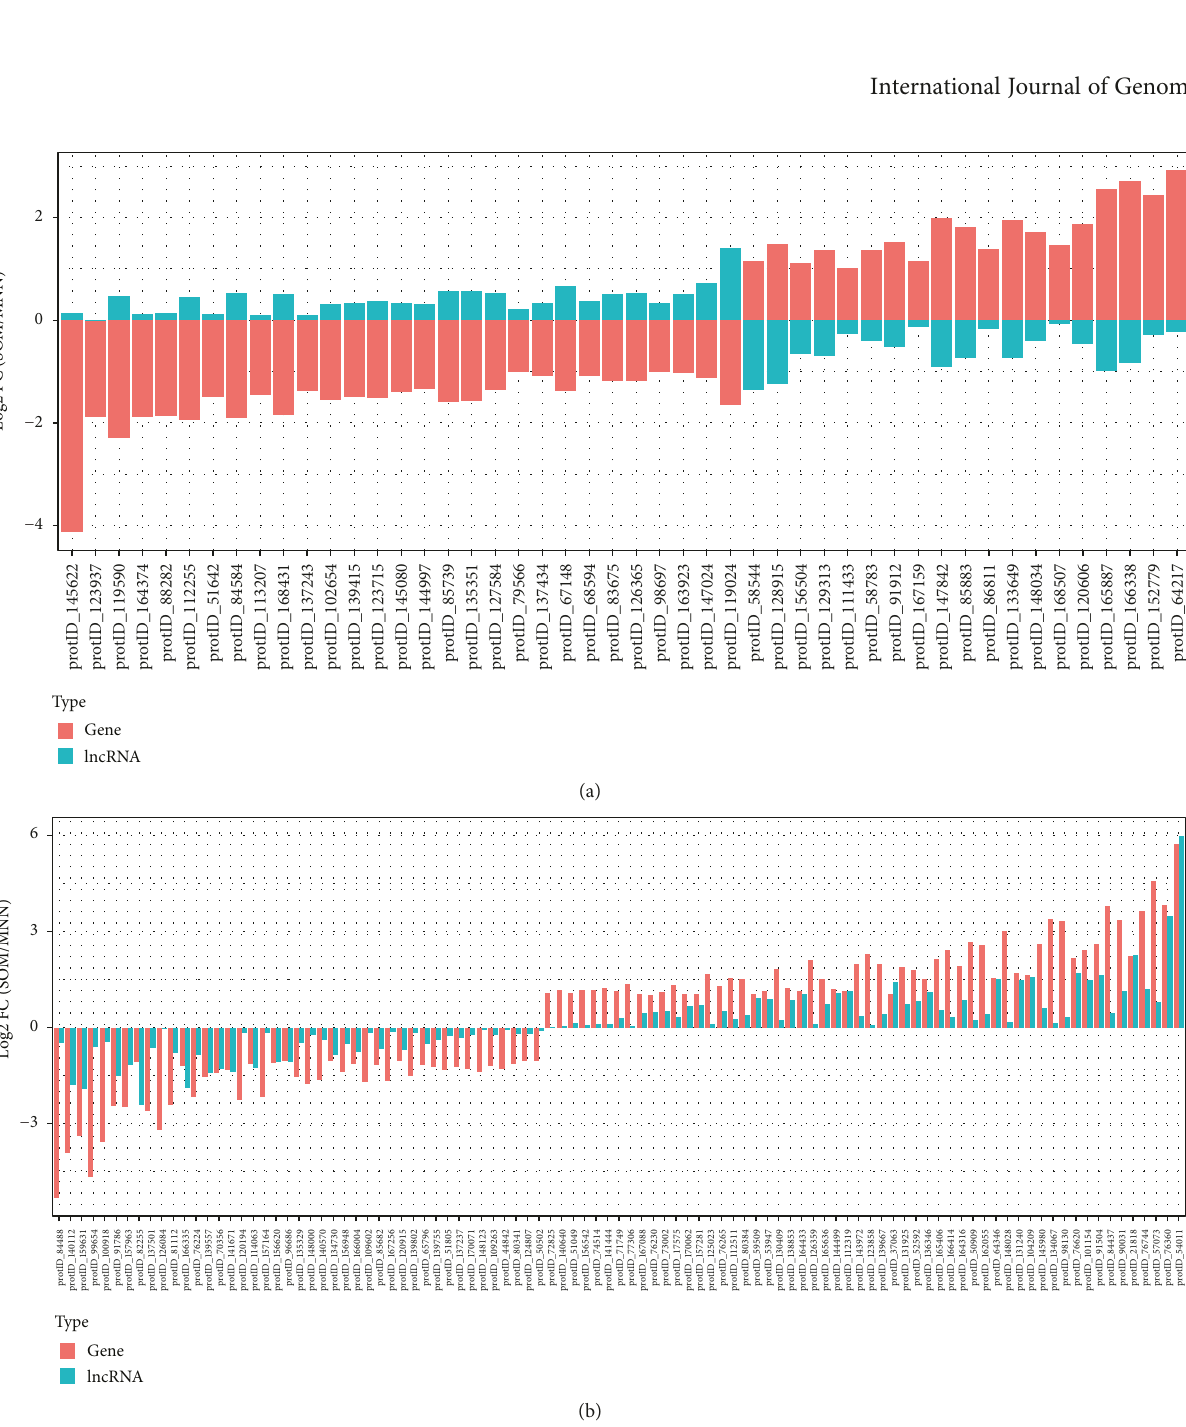
Figure 6: Expression pro fi les of 147 C. puteana DE genes and their linked upstream lncRNAs, showing opposite (a) and same (b) expression trends in SOM vs. minimal MNN